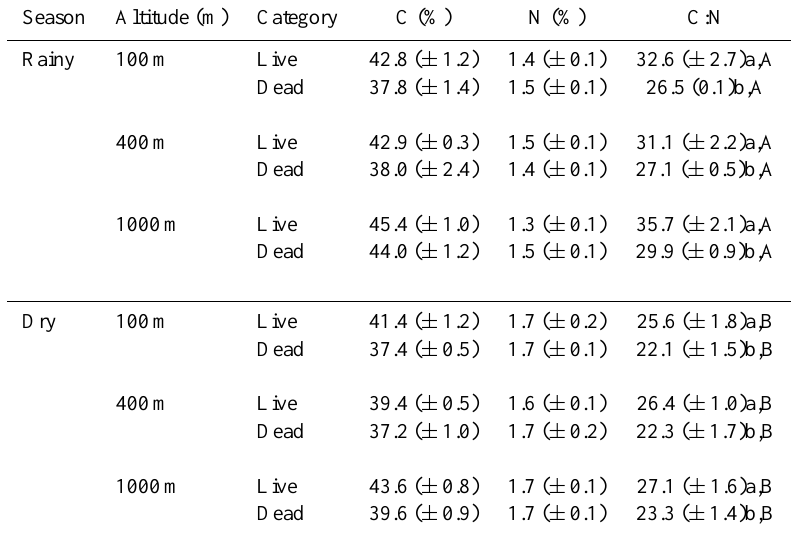
Table 3. Concentrations of carbon and nitrogen and C:N ratio of fine roots ( < 2mm) at different altitudes in rainy (January, 2007) and dry (August, 2007) months. Values represent mean and standard error (in parenthesis) of four replicates per